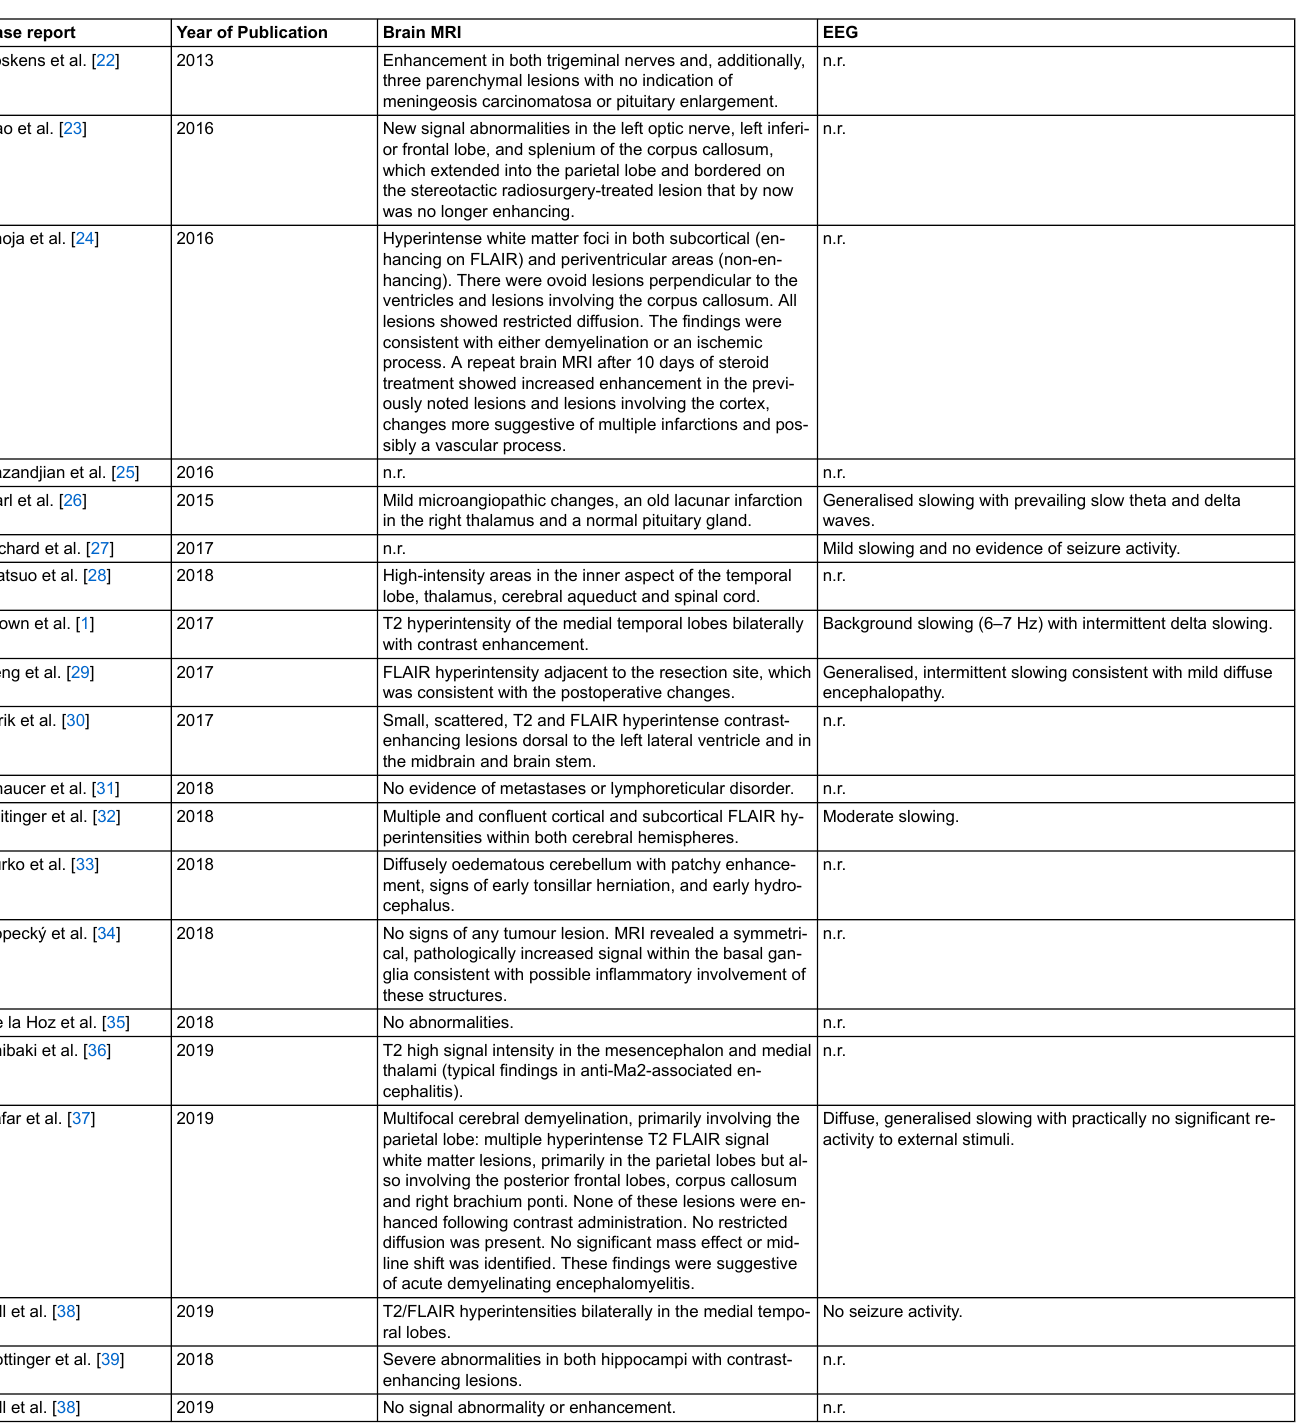
vated protein concentrations. The glucose concentration is usually normal. Polymerase chain reaction assays of CSF for herpes simplex virus type 1, herpes simplex virus type 2 and varicella zoster virus must be ordered. In addition, cytological examination of CSF is recommended. A cerebral MRI should be performed to detect brain metas- tases and to exclude ischemia or intracranial haemorrhage. Nonconvulsive status epilepticus must be ruled out by recording an EEG. Blood and urine cultures must be drawn. A complete blood count, a C-reactive protein